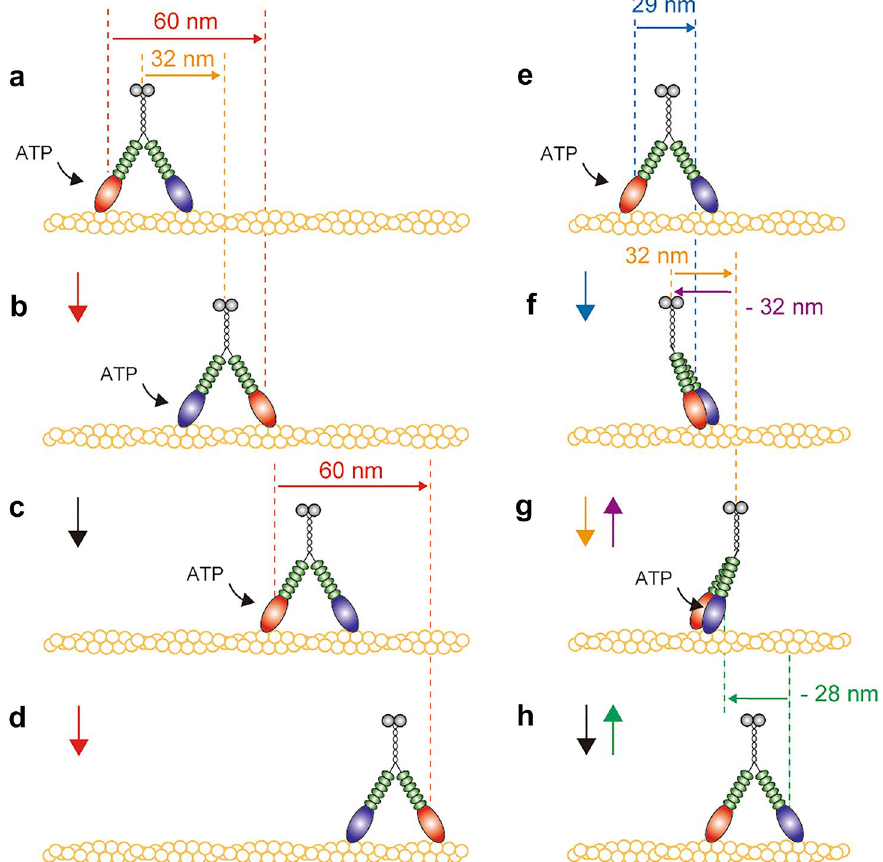
Figure 5. Walking model of MYA2. Left ( a – d ), large hand-over-hand steps; right ( e – h ), small inchworm-like steps. Colors denote the following: N-terminal motor domain (red or blue), lever arm (six calmodulins, green), coiled-coil domain (black), and the globular C-terminal tail domain (gray). Red, blue, and green arrows indicate the step of the MD for large, small, and backward steps, respectively, observed using FIONA. Orange and purple arrows indicate the step of the C-terminal tail for forward and backward steps, respectively, observed by optical trapping